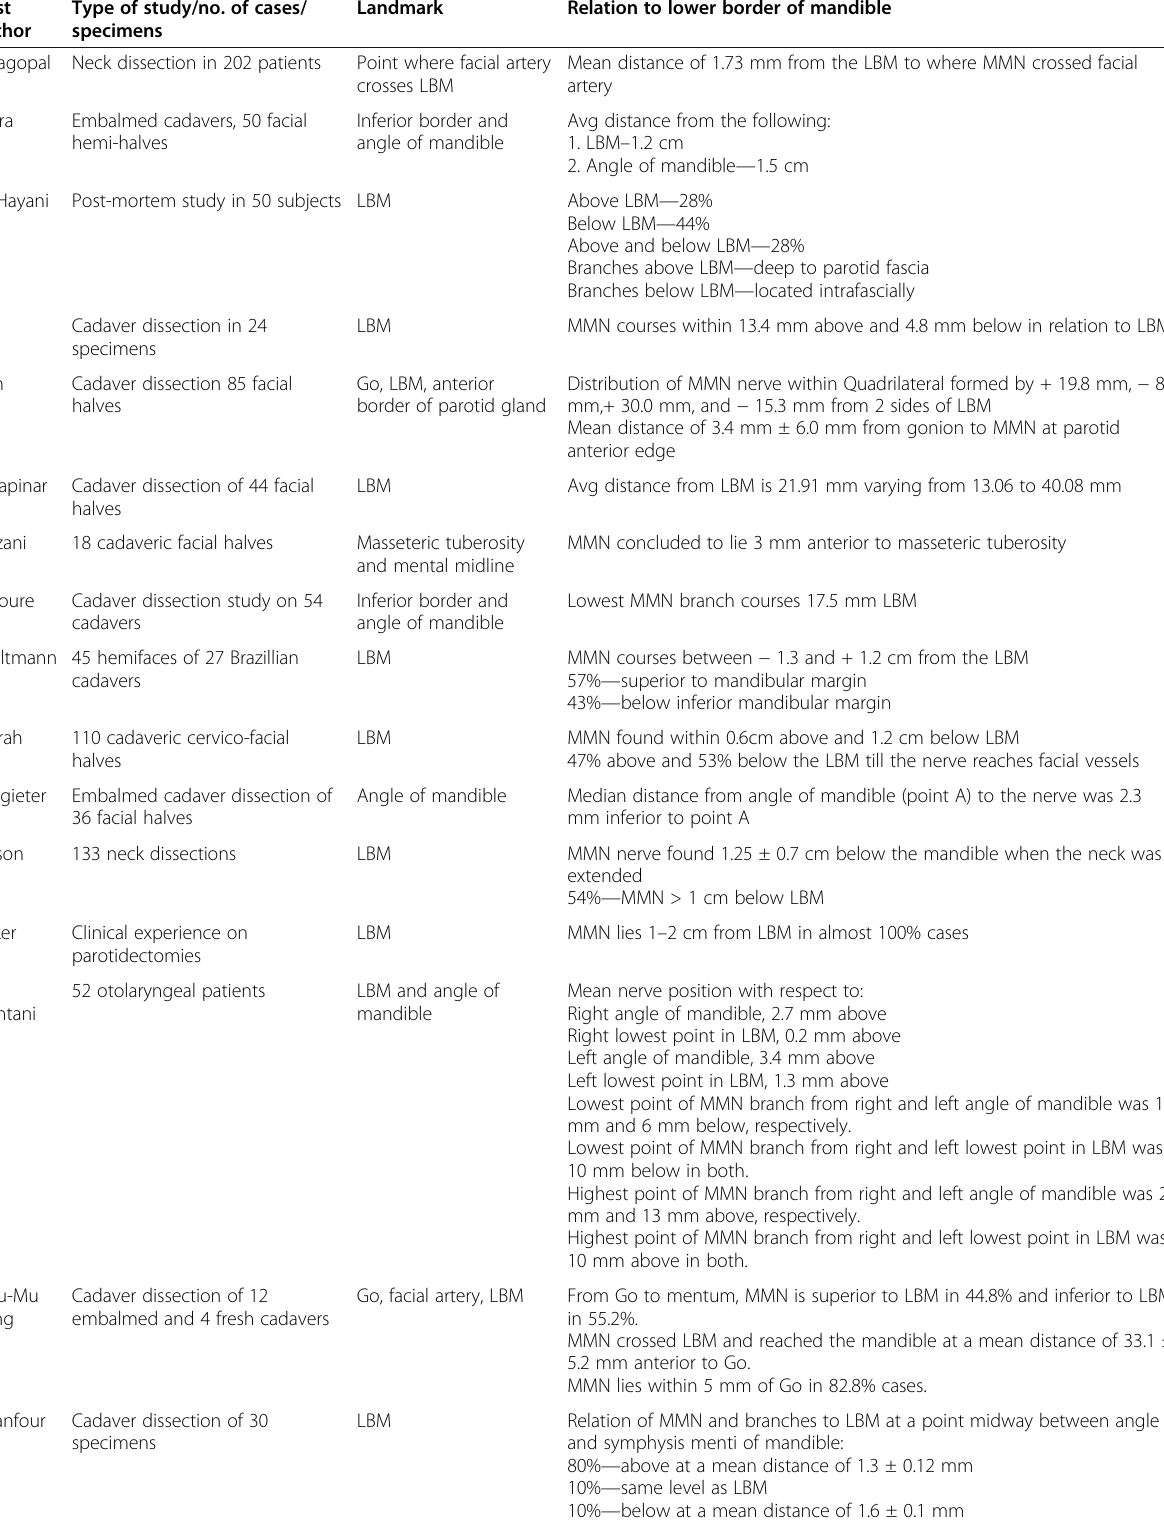
Table 2 Relation of MMN to lower border of